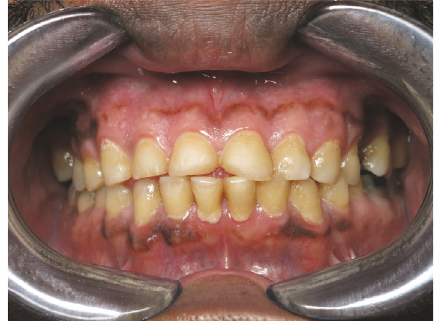
Figure 3: Short, unesthetic maxillary anterior